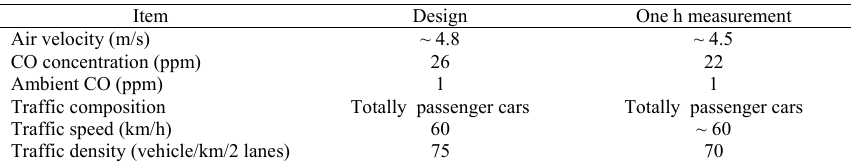
Table 3: Comparison of short-term measurements with the ventilation design and calculation, southern tunnel